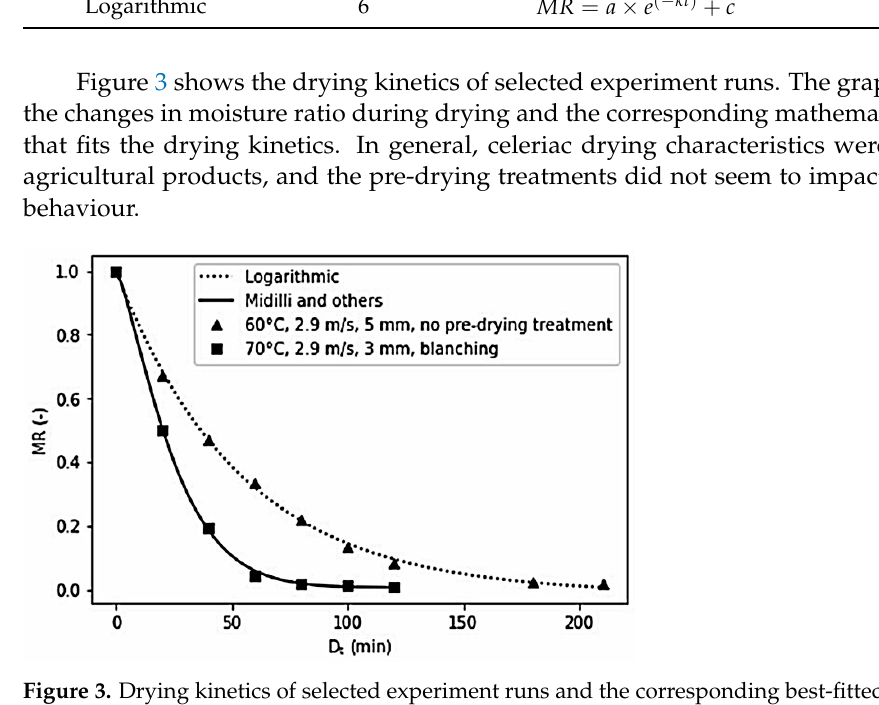
Figure 3. Drying kinetics of selected experiment runs and the corresponding best-fitted model.